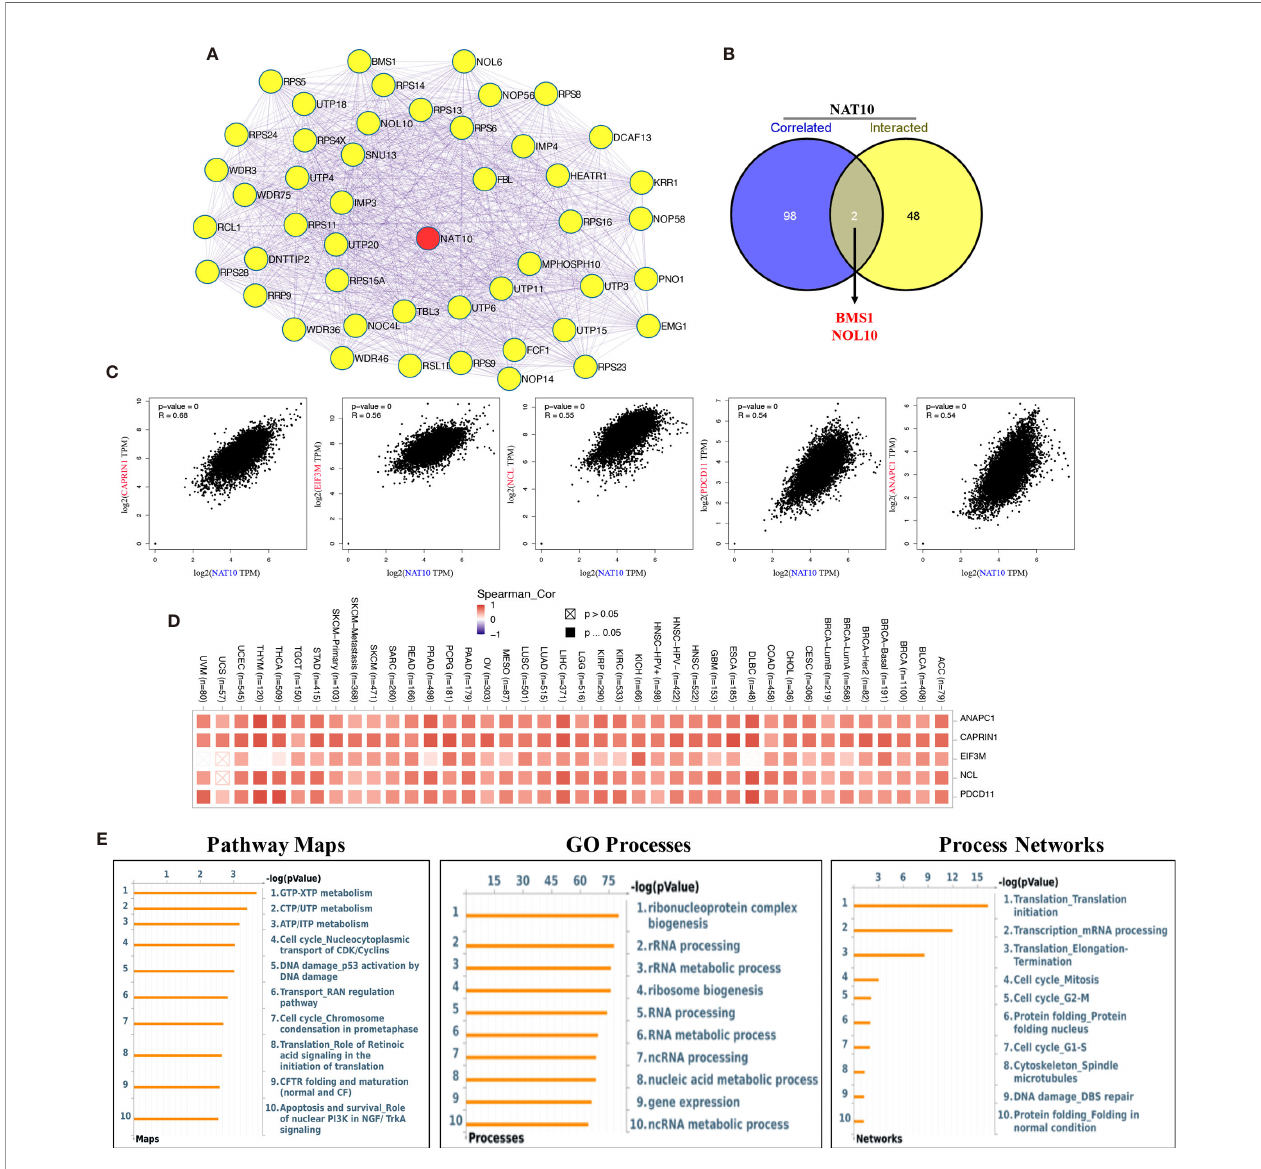
FIGURE 7 | NAT10-related gene enrichment analysis. (A) We obtained the available experimentally determined top 50 NAT10-binding proteins using the STRING database. (B) An intersection analysis of the NAT10-binding and correlated genes was applied. (C) Top fi ve (including ANAPC1, CAPRIN1, EIF3M, NCL and PDCD11) most NAT10-correlated genes in TCGA projects was analyzed by using the GEPIA2. (D) The corresponding heatmap data between NAT10 with these fi ve genes in the detailed cancer types was displayed. (E) Pathway maps analysis (left), GO process analysis (middle) and Process networks analysis (right) of NAT10- binding and correlated